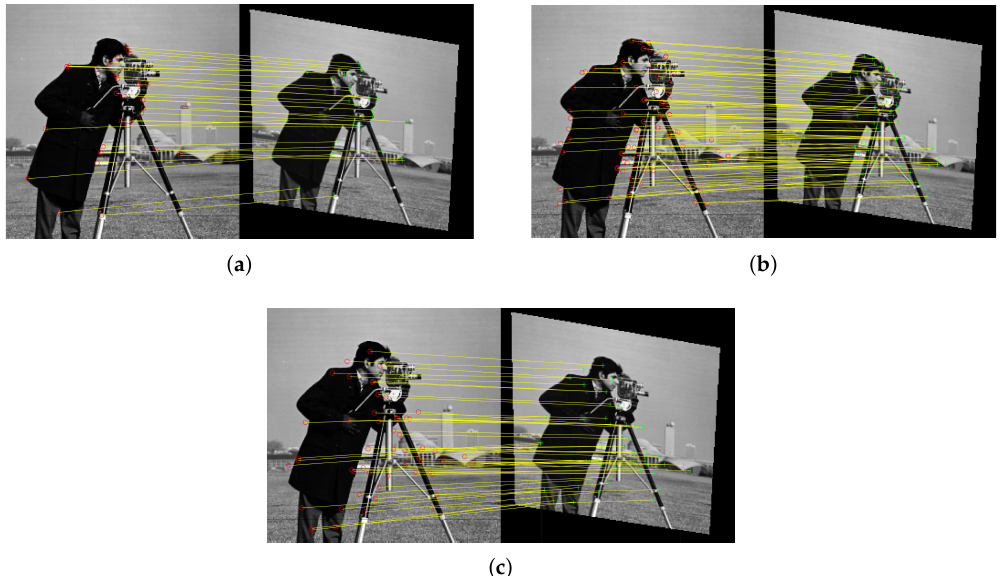
Figure 2. Different keypoint pairs detected by different keypoint detectors. ( a ) BRISK. ( b ) KAZE. ( c ) SURF.